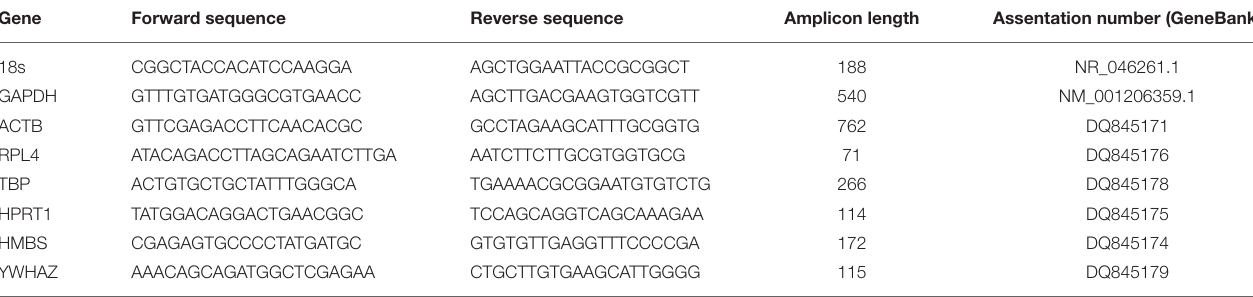
TABLE 2 | List of reference genes a . Gene